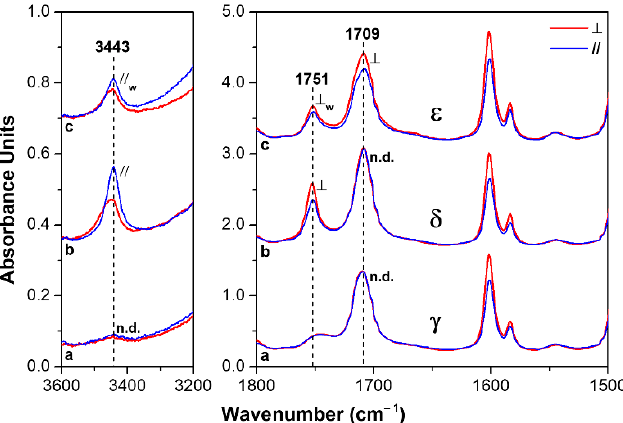
Figure 6. Polarized FTIR spectra as taken with polarization plane parallel (blue lines) and perpen- dicular (red lines) to the film stretching direction, for two spectral ranges (3600–3200 cm − 1 and 1800–1500 cm − 1 ), for axially oriented s-PS semicrystalline films exhibiting different crystalline phases, after comparable uptake of HA guest molecules: ( a ) γ form; ( b ) δ form: ( c ) ε